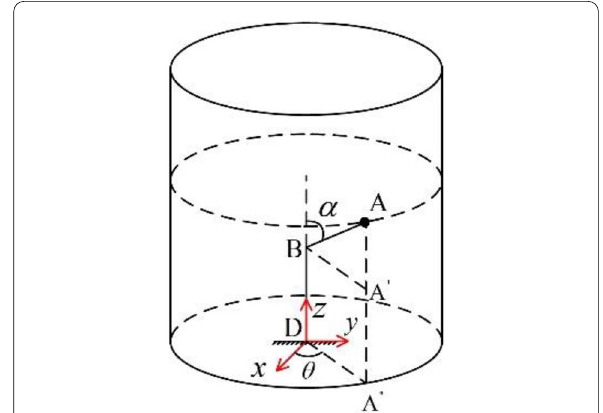
Figure 16 Position calculation model of the cylindrical tank